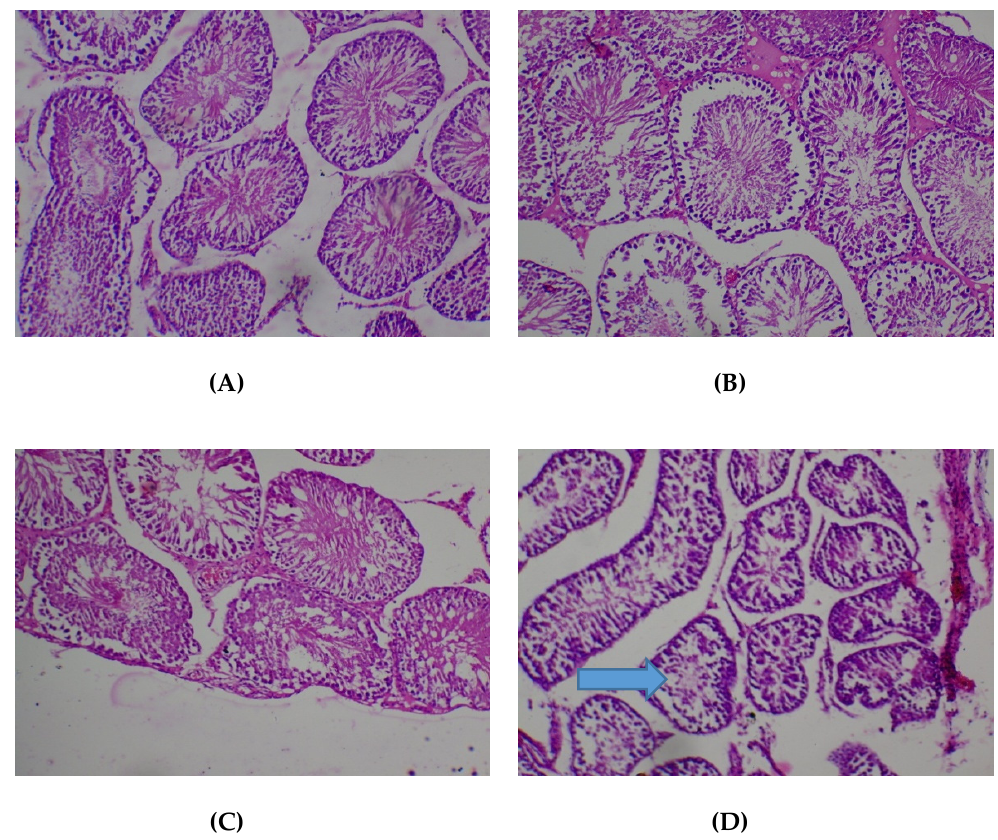
Figure 8. Histopathological presentation of rat testes. ( A ) represents the control group treated with distilled water (Normal); ( B ) represents the group treated with 80 mg/kg T. occidentals extract (Normal); ( C ) represents the group treated with 400 mg/kg T. occidentalis extract (Normal) and ( D ) represents the group treated with 2000 mg/kg T. occidentalis extract (mild testicular atrophy, spermatogenic series lining diminished, no luminal spermatozoa) — see arrow ( × 400). The normal slides ( A , B , D ) show tubules lined by spermatogenic series cells and containing numerous luminal spermatozoa.